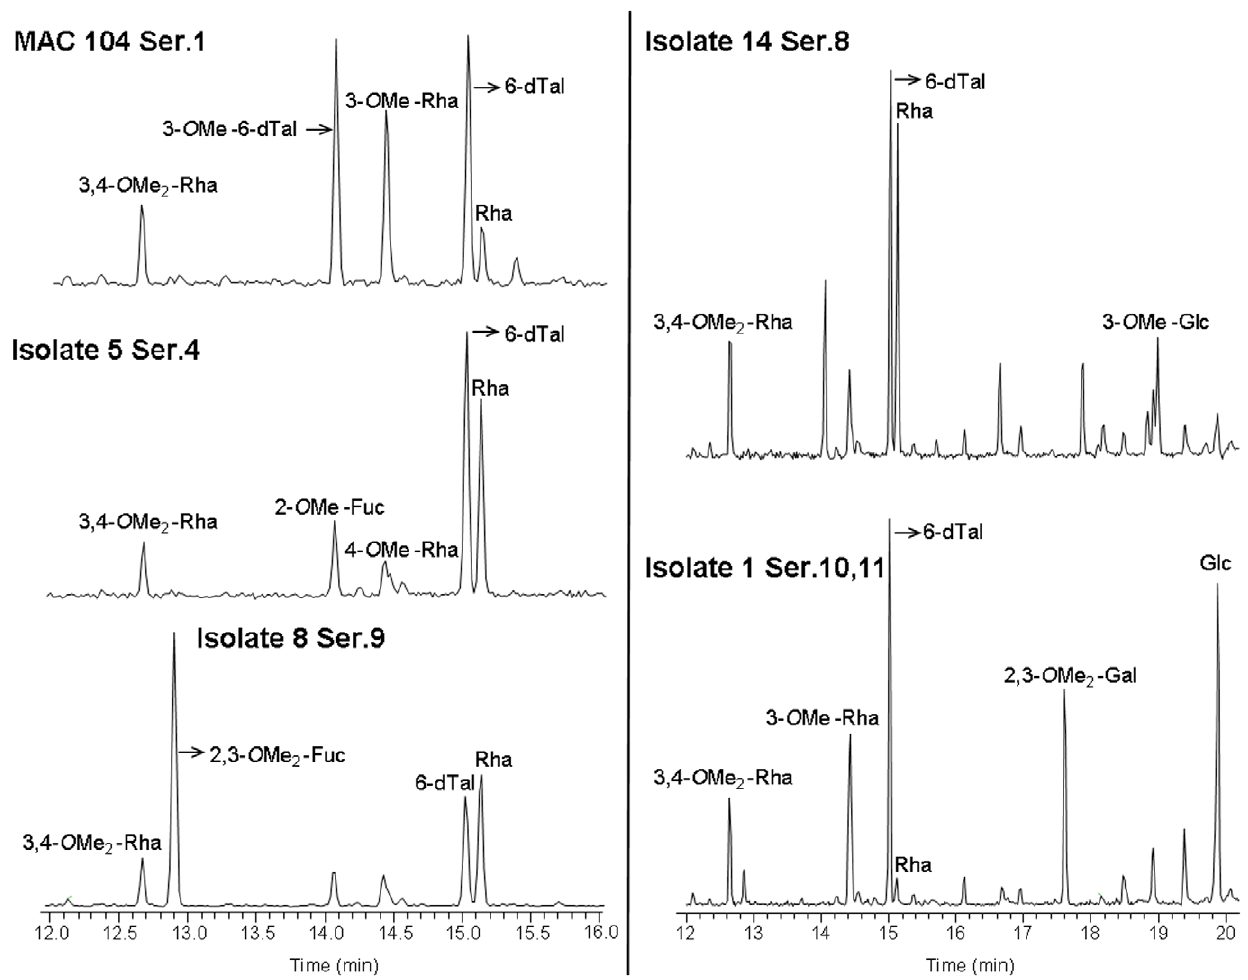
Figure 3. GC profiles of purified GPLs from M.avium spp. 1, 5, 8, 14 and 104. GPLs were hydrolyzed using 2 M trifluoroacetic acid, reduced and acetylated. Aditol acetate GC profiles were obtained and peaks were identified by MS analyses. Shown are representative plots for each serovar (N=3). Note that the horizontal axis for isolates 104, 5 and 8 (left side of figure) differs from isolates 14 and 1. Methyl (Me); Rhamnose (Rha); Talose (Tal); Fucose (Fuc); Galactose (Gal); Glucose